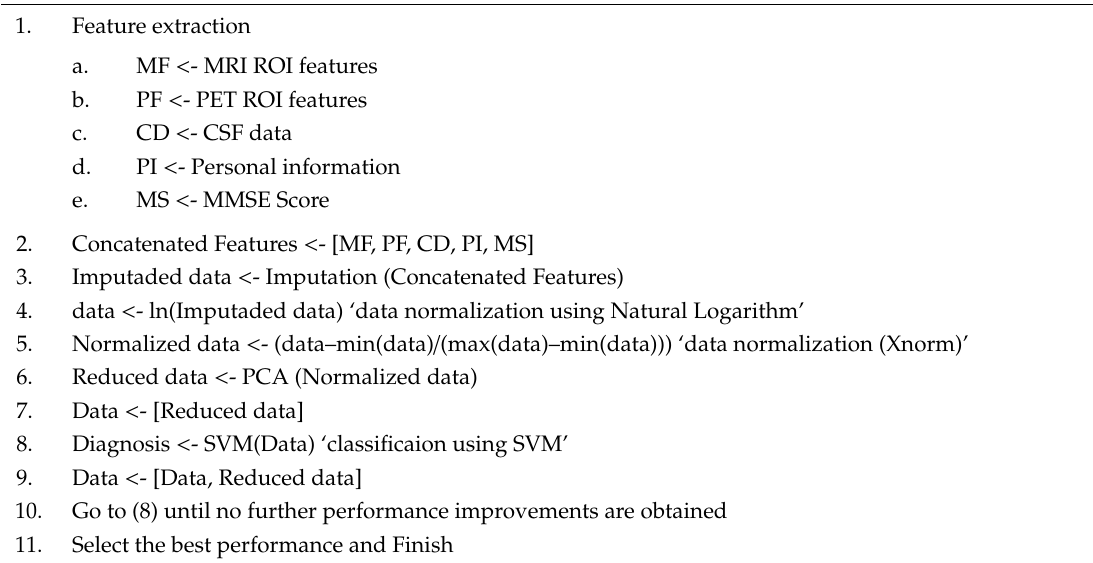
Algorithm 1. The steps of the algorithm of the